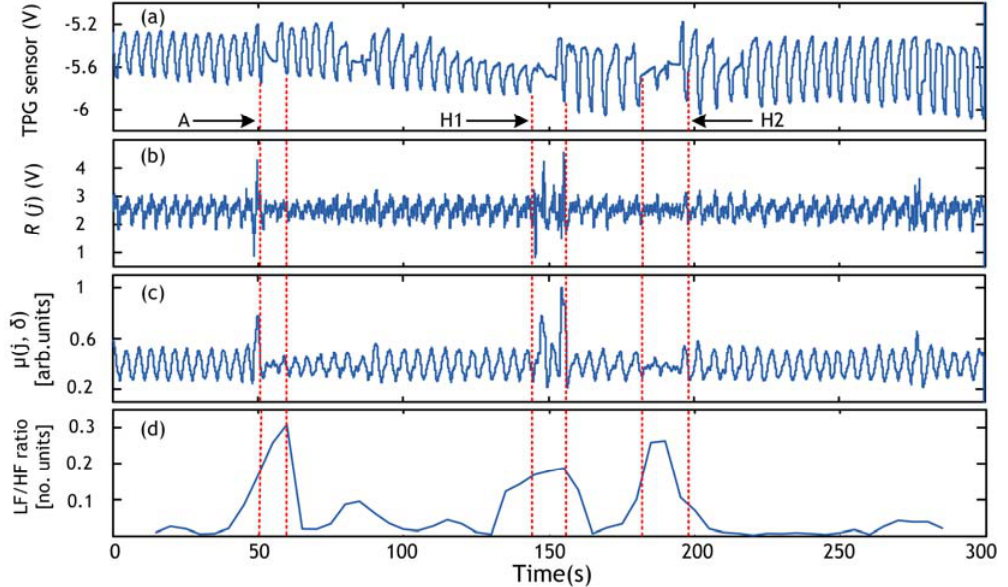
Figure 12. Hypopnea detection using respiratory cycle variability (RCV) for record 3. (a) Respiration signal obtained with commercial TPG sensor. (b) PVDF sensor output. (c) Respiration signal derived from (b) using local energy calculation. (d) LF/HF ratio. Hypopnea episode and abnormal respiration pattern are shown by broken lines. “H1” and “H2” represent hypopnea episodes whereas “A” represents abnormal respiration